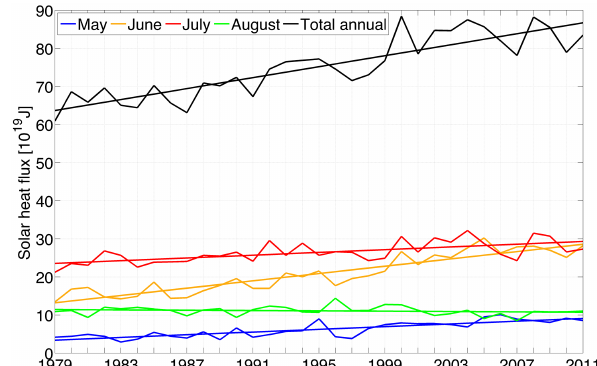
Figure 5. Arctic-wide total solar heat flux under sea ice ( Q T ) (black) and monthly Arctic-wide solar heat input for May to August (colored) and its trend from 1979 to 2011. The data are corrected for the trend in sea ice concentration. Areas that were not ice covered at any time in 2011 or during a certain month in 2011 are excluded from the